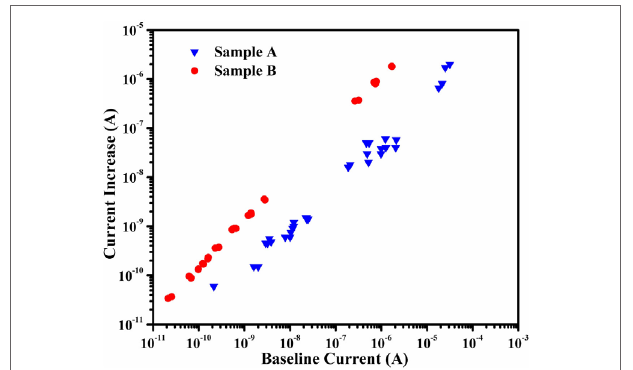
FigUre 4 | Plot of the emission current increase due to the introduction of hydrogen as a function of the current in vacuum immediately prior to the introduction of hydrogen (baseline current) from Samples A and B. A clear linear relationship can be seen such that the magnitude of emission current improvement increases with increasing baseline current. The varying baseline current levels at each temperature are a result of this plot including data from the samples in both their as-grown and hydrogenated states.